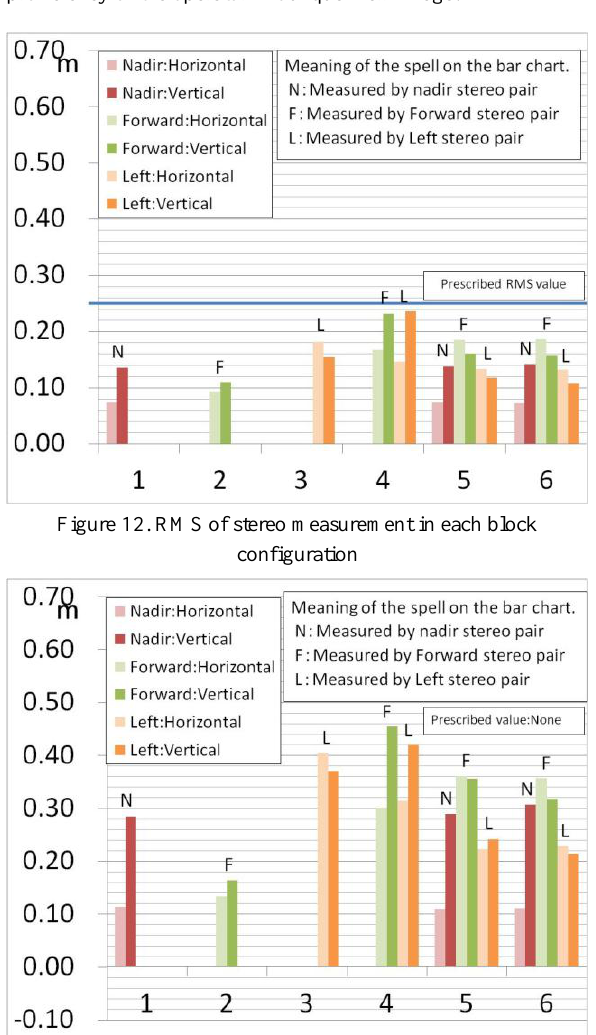
Figure 13. Maximum residual of stereo measurement in each block